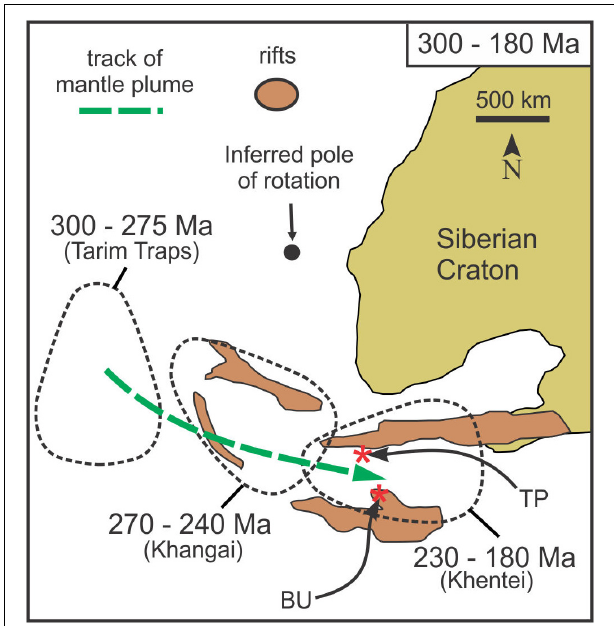
FIGURE 13 | Reconstruction of the movement of the Mongolian mantle plume and the location of the magmatic complexes in northern Mongolia and Transbaikalia (modified after Yarmolyuk and Kuzmin, 2011, 2012; Dostal et al., 2014). Dashed lines show the migration of magmatism and the positions of the Mongolian plume at 300 to 275 Ma, 270 to 240 Ma, and 230 to 180 Ma. The arrow is a tracer of Mongolian plume. TP—Tukhum pluton; BU—Bayan Ulan